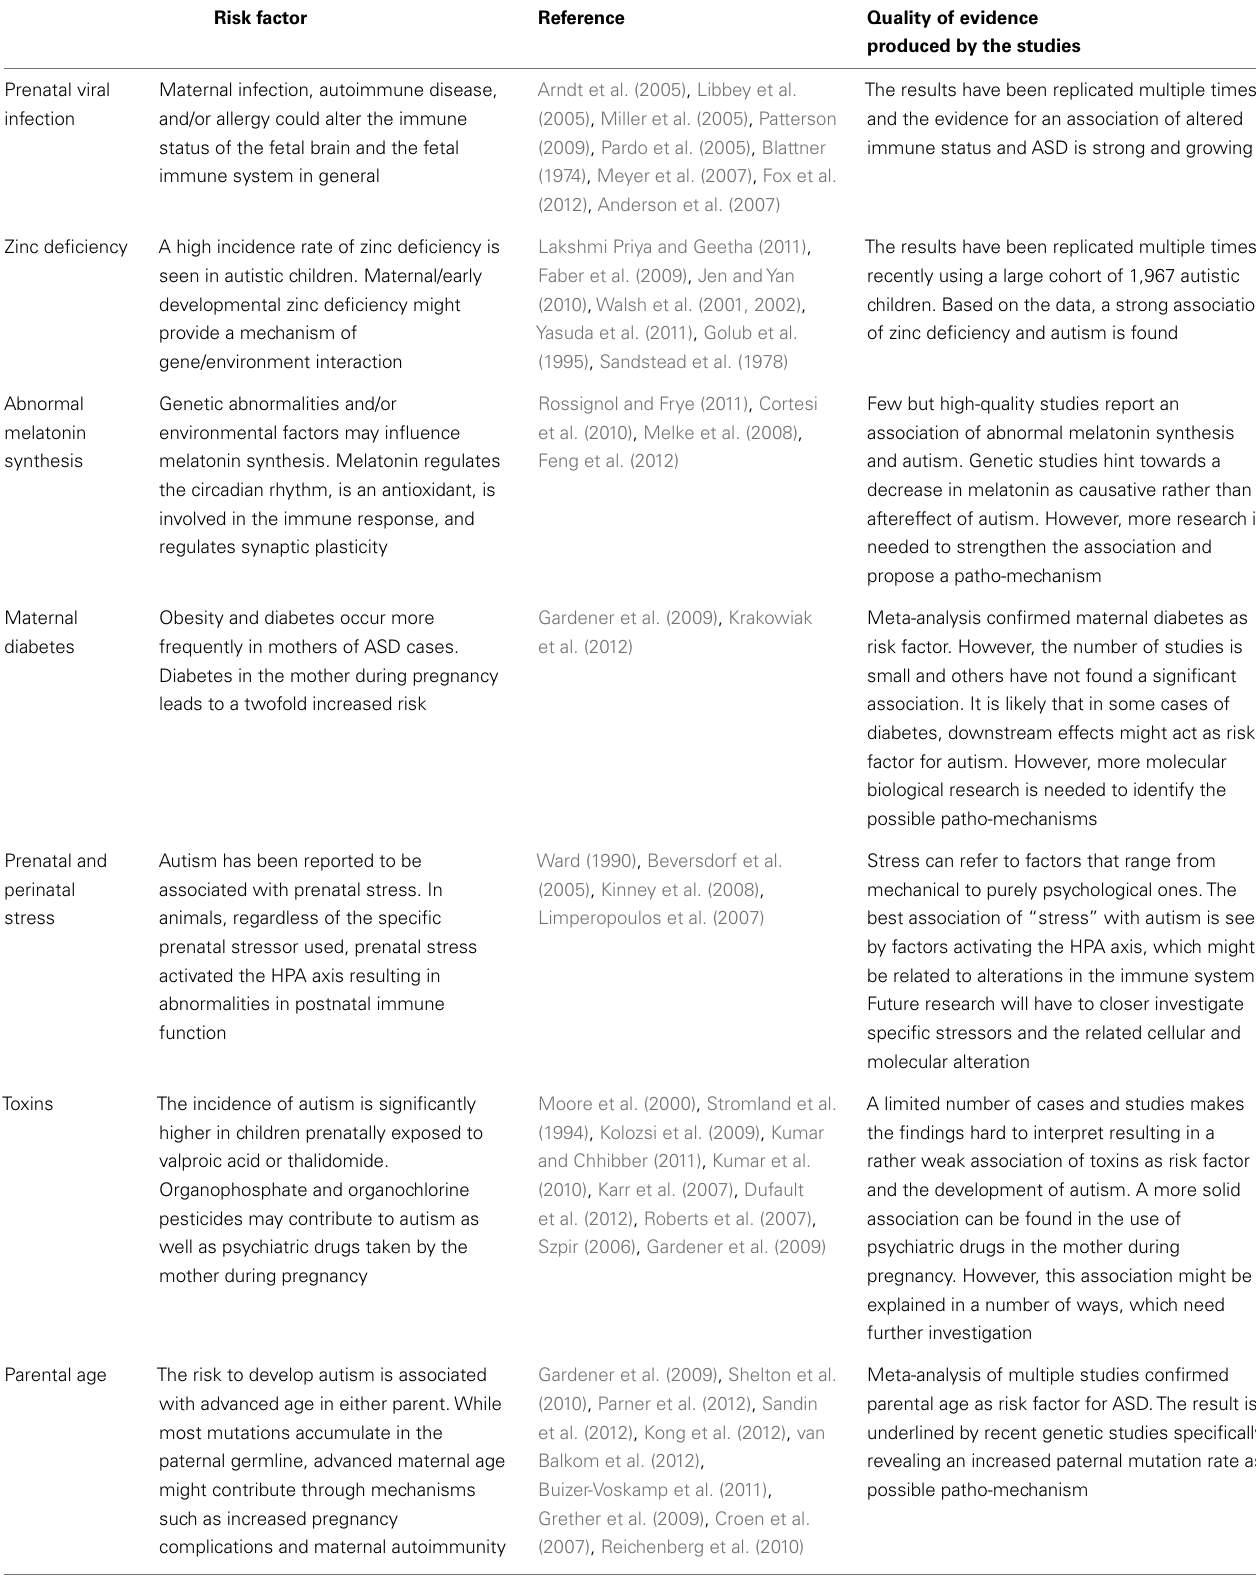
Table 1 | Summary of the presented environmental risk factors for